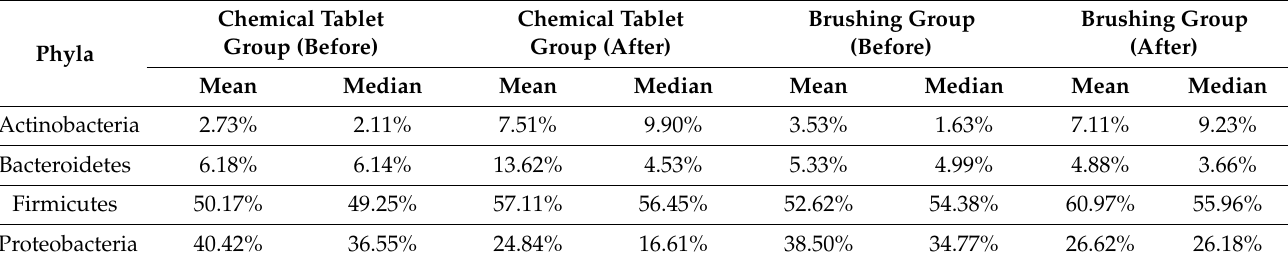
Table 2. The mean and median of phyla in each